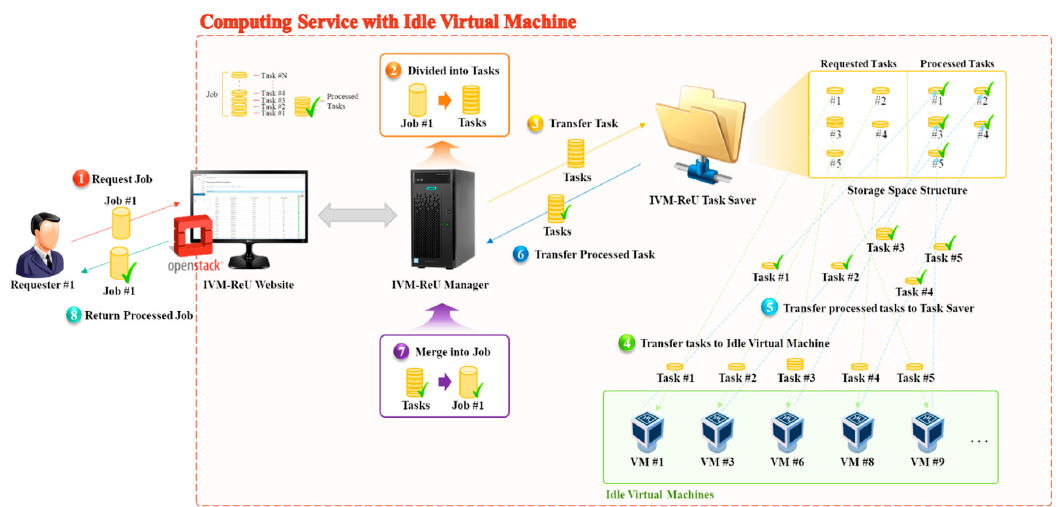
Figure 2. Computing service control flow in IVM–ReU.